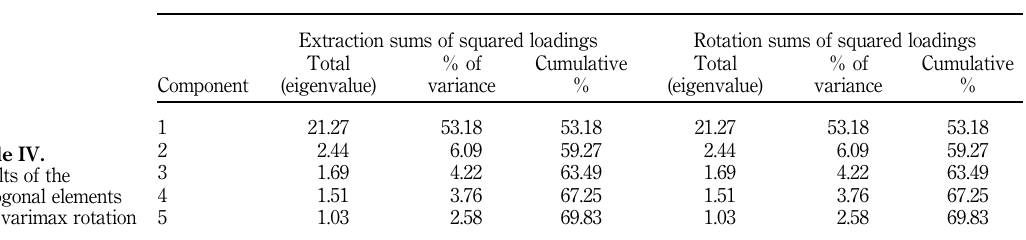
Table IV. Results of the orthogonal elements with varimax